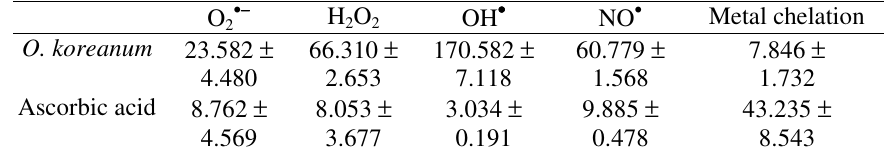
Table 2. The free radical scavenging and metal chelating activities (IC acetate fraction of O.